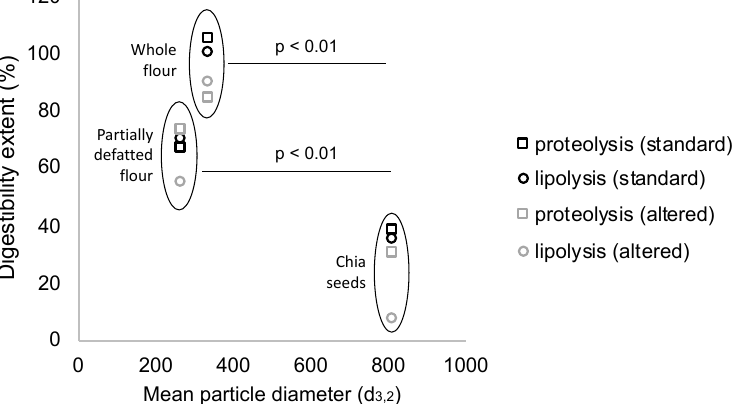
Figure 2. Milling process of chia seeds reduces particle size, which significantly increases lipid and protein digestibility in chia flours as compared to chia seeds (after simulation of mastication) (data are expressed as mean values from three repetitions).